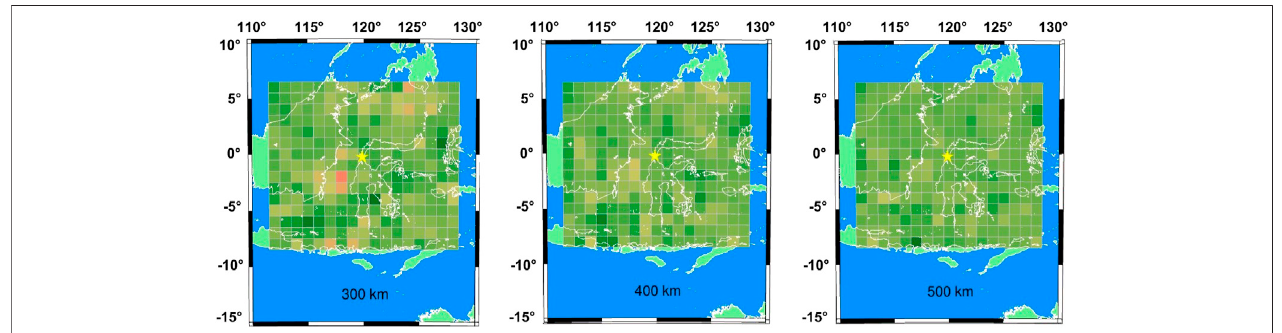
FIGURE 7 | Tomography results of the 2018 Palu Earthquake at 10.16 UT in difference altitude.